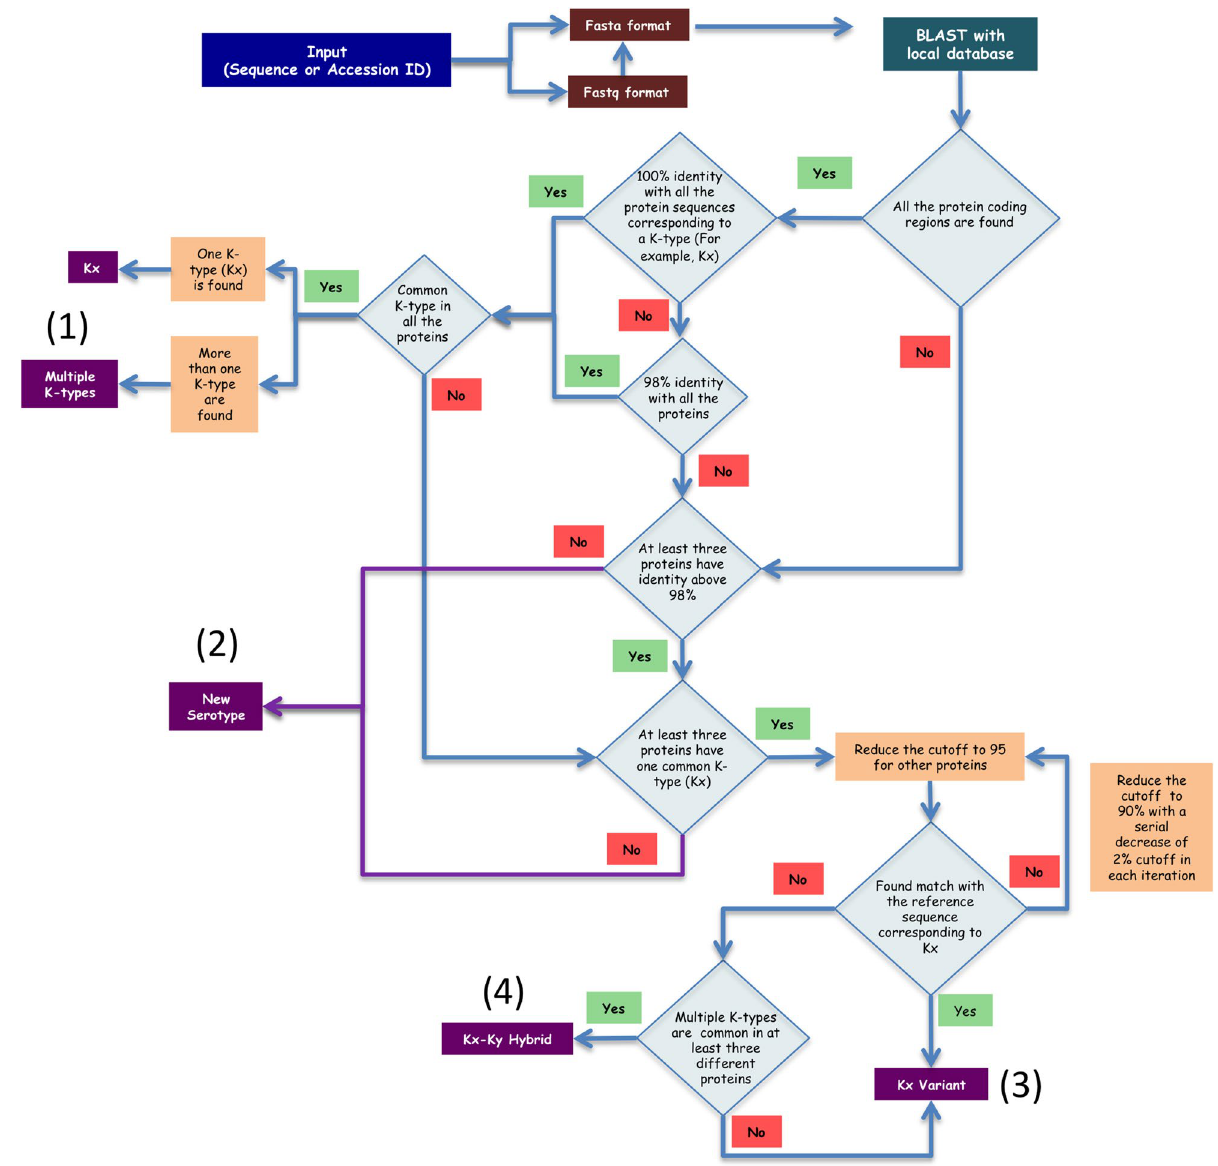
Figure 2. Flowchart describing the methodology implemented in K-PAM for K-typing using multiple gene/ protein sequences. Note that the methodology is explained here by considering the protein sequences as example. The final serotype prediction is indicated in a violet colored